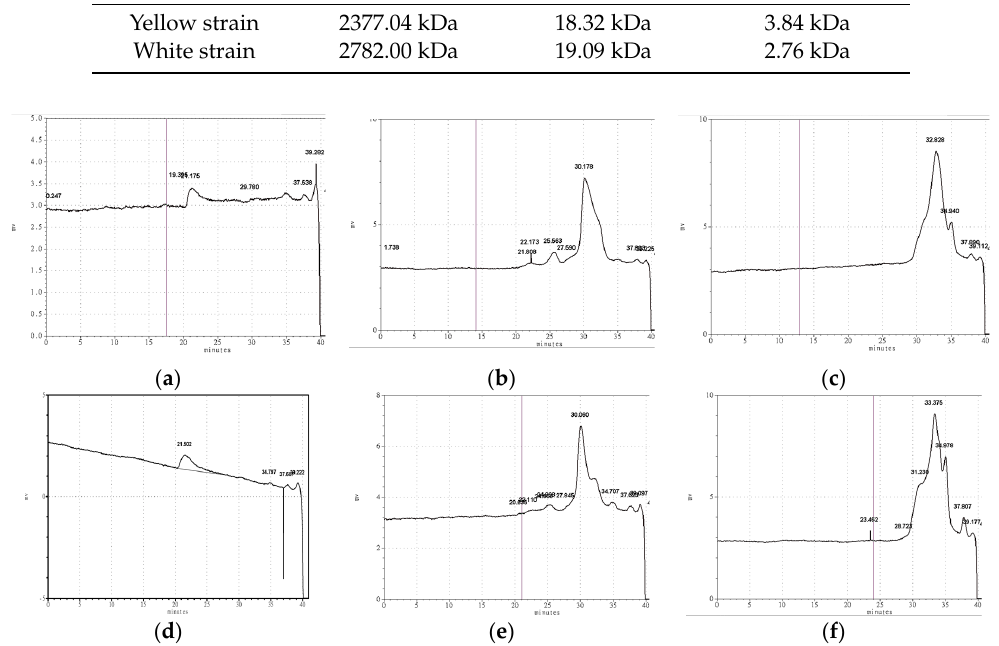
Figure 3. Molecular weight distribution of ( a ) FVY-40, ( b ) FVY-60, ( c ) FVY-80, ( d ) FVW-40, ( e ) FVW-60, and ( f ) FVW-80 determined by high-performance size-exclusion chromatography.